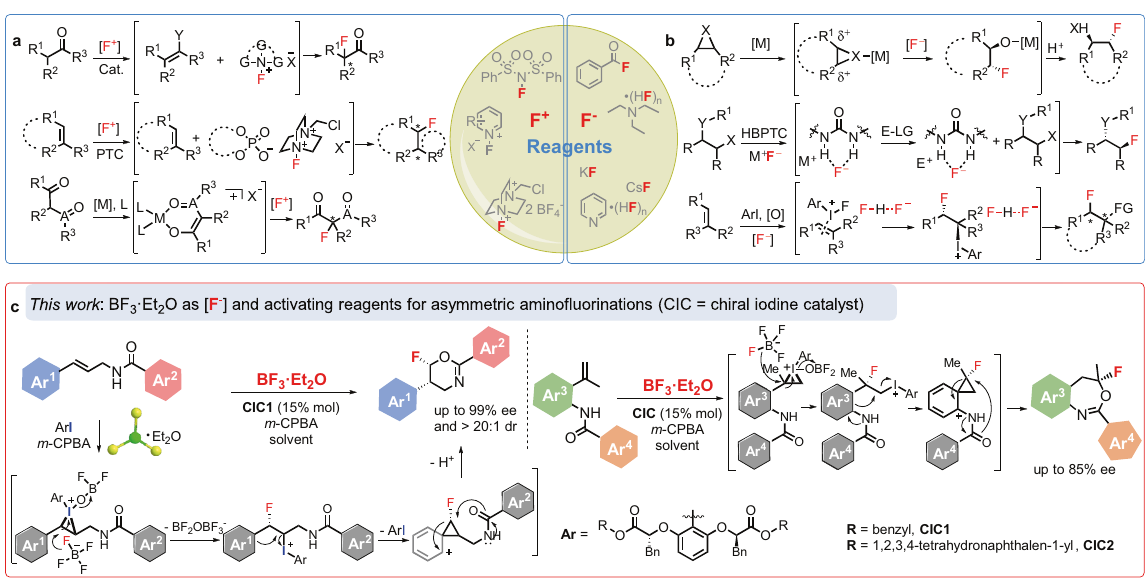
Fig. 1 Examples of common fl uorine reagents applied in asymmetric fl uorinations. a Asymmetric fl uorinations using electrophilic fl uorine (F + ) reagents. b Asymmetric fl uorinations using nucleophilic fl uorine (F − ) reagents. c The fi rst example of using BF 3 ·Et 2 O as F − Reagent for asymmetric fl uorinations (this work). [F + ], electrophilic fl uorine reagents; [F − ], nucleophilic fl uorine reagents; PTC, phase-transfer catalyst; [M], metal catalyst; L, ligand;